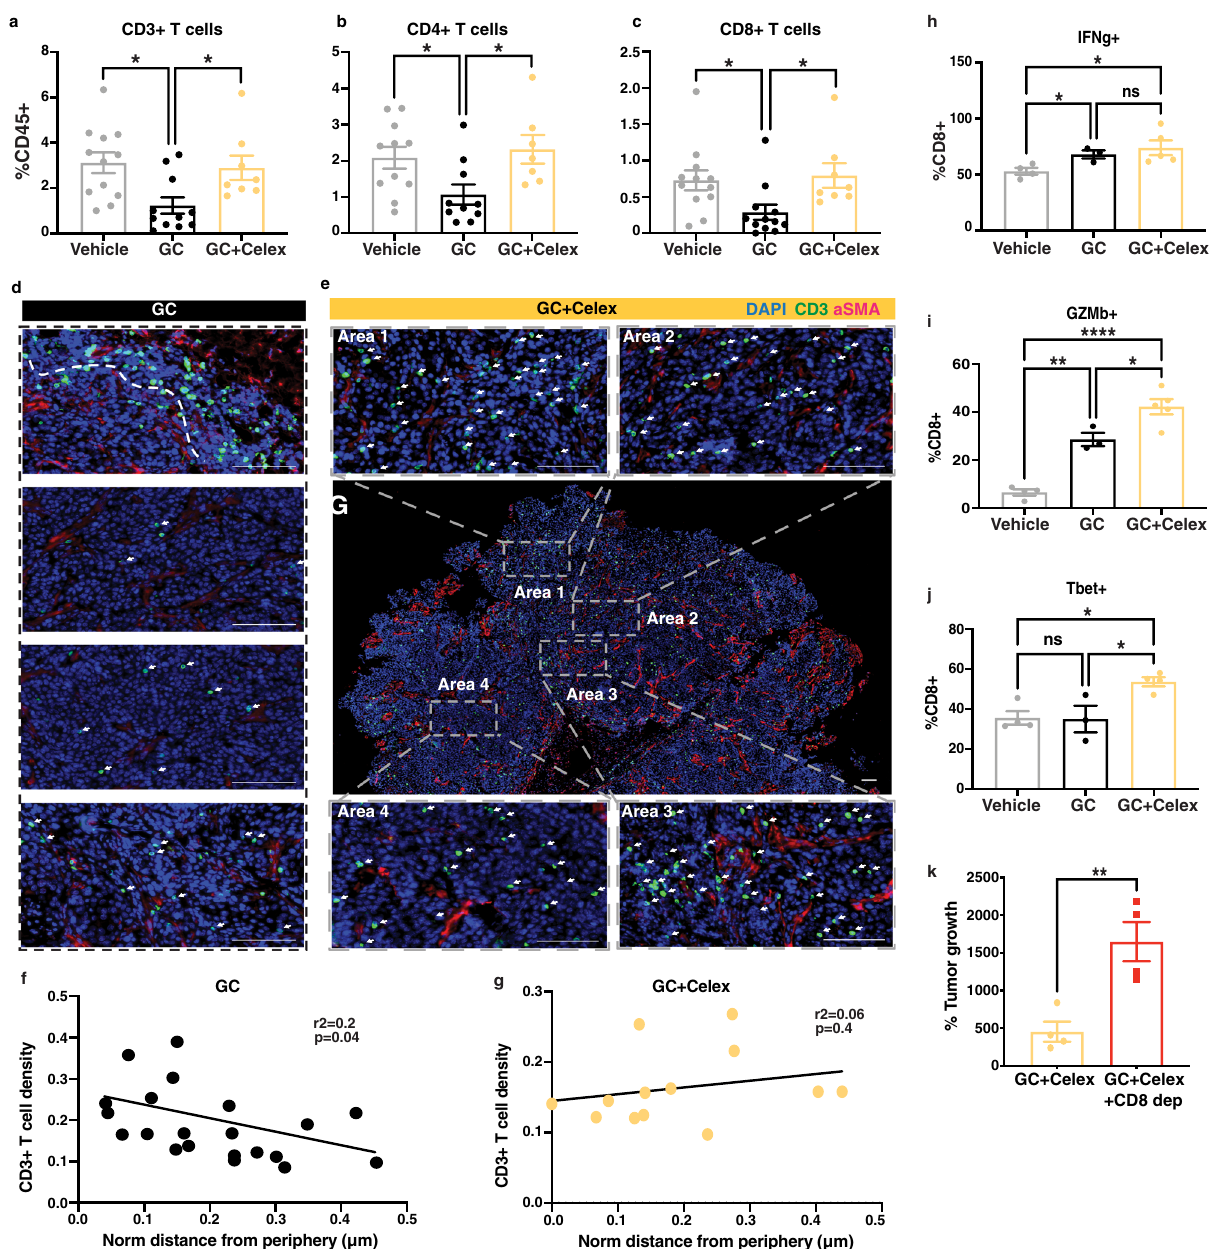
Fig. 6 iDAMP blockade-mediated tumor suppression is dependent on functional CD8 + T cells. a – c Quanti fi cation of CD3 + T cells and their subpopulations of CD4 + and CD8 + T cells from dissociated G69-tumor tissues treated with vehicle ( n = 12 biologically independent samples), GC ( n = 11 biologically independent samples), or GC + celecoxib ( n = 8 biologically independent samples) for two cycles. Data are presented as mean values ± SEM. (One-way ANOVA-Tukey ’ s multiple comparisons test. CD3: GC vs Vehicle p = 0.01, vs GC + Celex p = 0.049; CD4: GC vs Vehicle p = 0.047, vs GC + Celex p = 0.043; CD8: GC vs Vehicle p = 0.048, vs GC + Celex p = 0.048). d , e Immuno fl uorescence analysis of CD3 + T-cell in fi ltration in vehicle, GC, and GC + Celecoxib-treated G69 tumors. Selected ROIs (1 – 4) are representative areas that depict CD3 + T-cell in fi ltration in the tumor core and decreased presence of CD3 + T cells in the tumor periphery (Scale bar: 100 μ m; Images representative of n = 3 independent experiments). f , g Relative CD3 + T cells density as a function of the distance from tumor periphery for GC ( n = 5 biologically independent samples) and GC + Celecoxib-treated ( n = 3 biologically independent samples) G69-tumor section. CD3 + T-cell density was calculated as described in materials and methods. Graphs depict CD3 + T cells density versus distance from tumor periphery for 3 – 5 ROIs from each sample. h – j Flow cytometric quanti fi cation of IFNg, GZMb, and Tbet expression in CD8 + T cells from vehicle ( n = 4 biologically independent samples), GC ( n = 3 biologically independent samples), and GC + Celecoxib-treated ( n = 5 biologically independent samples) G69-tumor tissues. Data are presented as mean values ± SEM. (One-way ANOVA-Tukey ’ s multiple comparisons test. IFNg: GC vs Vehicle p = 0.024, vs GC + Celex p = 0.042; GZMb: Vehicle vs GC p = 0.001, vs GC + Celex p < 0.0001, GC vs GC + Celex p = 0.019; Tbet: GC + Celex vs Vehicle p = 0.02, vs GC p = 0.03). k Endpoint G69-tumor volume from mice treated with IgG or anti-CD8a speci fi c antibody (200 mg/ unpaired t -test p = 0.006). Source data are provided as a Source data fi le. ns not signi fi